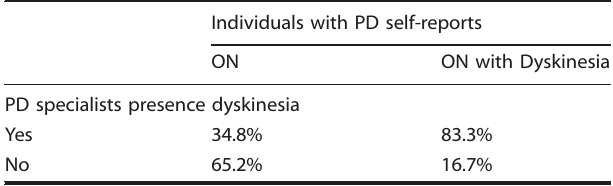
Table 2. Agreement between participants and clinical raters on the presence of